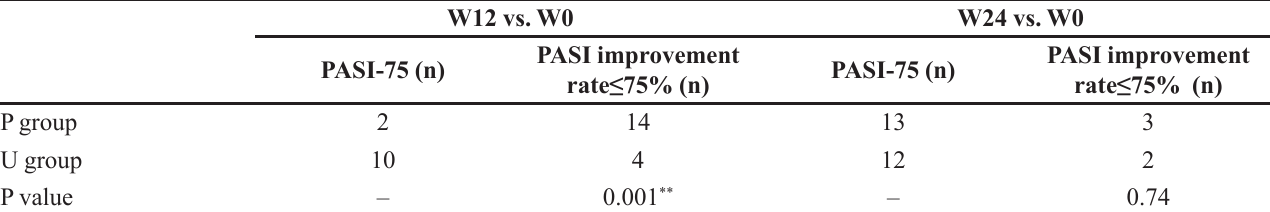
TABLE I - Kappa tests of PASI of P group and U group, comparing week 12 to week 0, week 24 to week 0 respectively